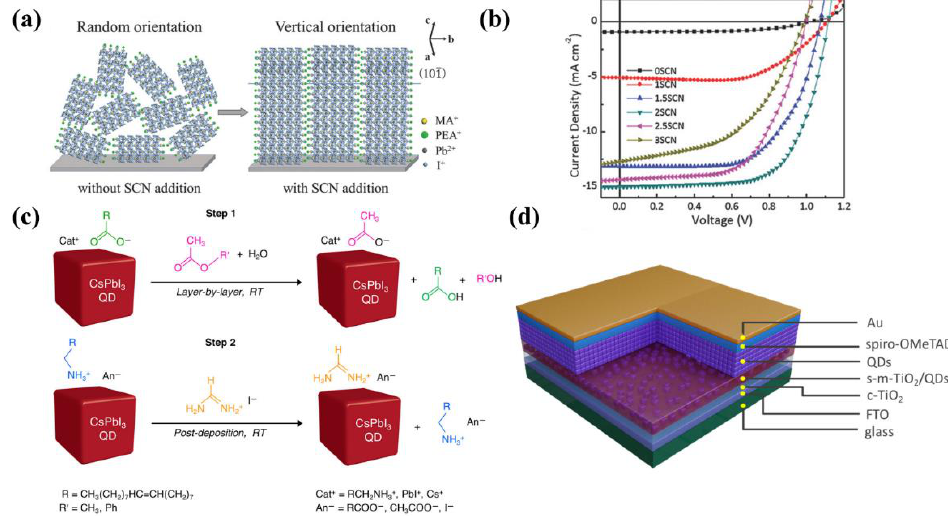
Figure 5. ( a ) Schematic illustration of inducing vertical crystal orientation in 2D perovskite. ( b ) The J – V curves for (PEA) 2 (MA) 4 Pb 5 I 16 -based devices with different amounts of NH 4 SCN. ( c ) A two-step solid-state QD ligand-exchange procedure of CsPbI 3 PQDs. ( d ) Schematic of the PQDSC based on CsPbI 3 QDs and Cs-treated m-TiO 2 layers. ( a , b ) Reprinted with permission from Ref. [92]. Copyright